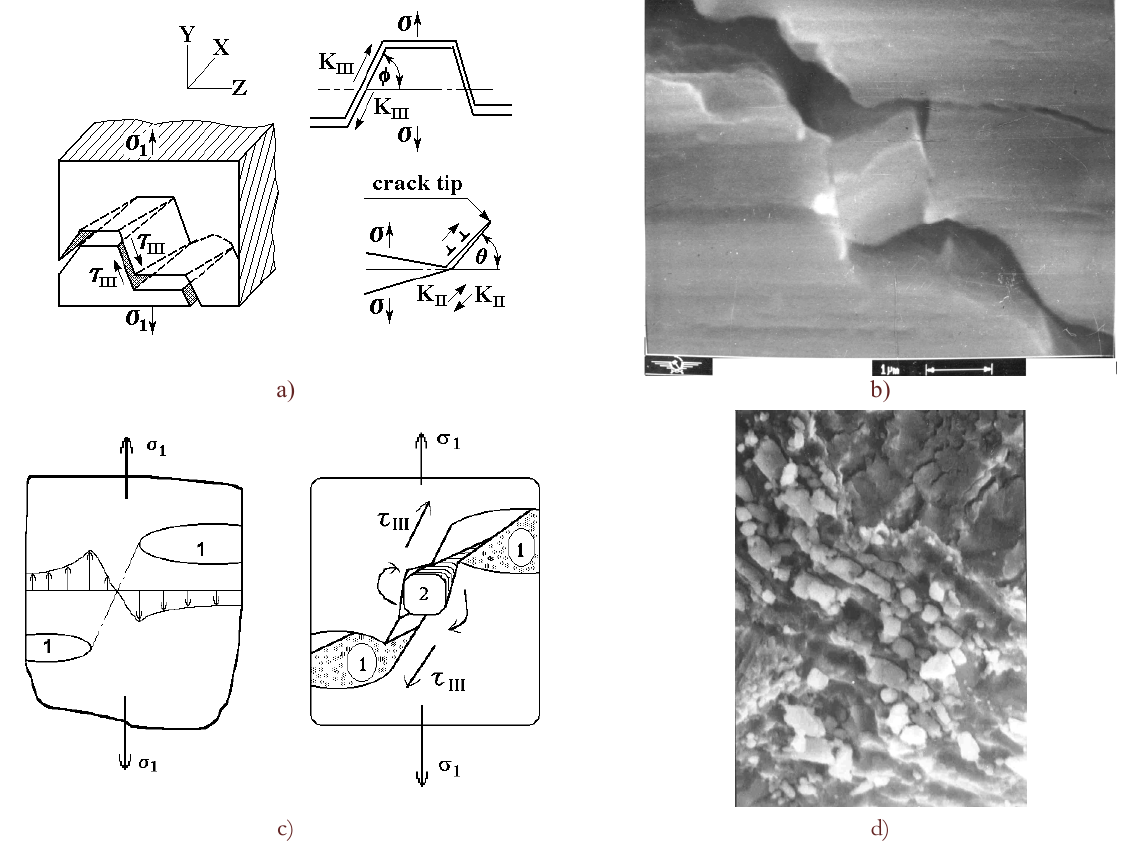
Figure 2: Combined mode-I, II and III opening of a fatigue crack under uniaxial stretch condition with (a) mesotunnels- 1, (b),(c) material rotations in crosspieces (2) between mesotunnels, and (d) cascade of oriented in chain cylindrical, ellipsoidal and spherical